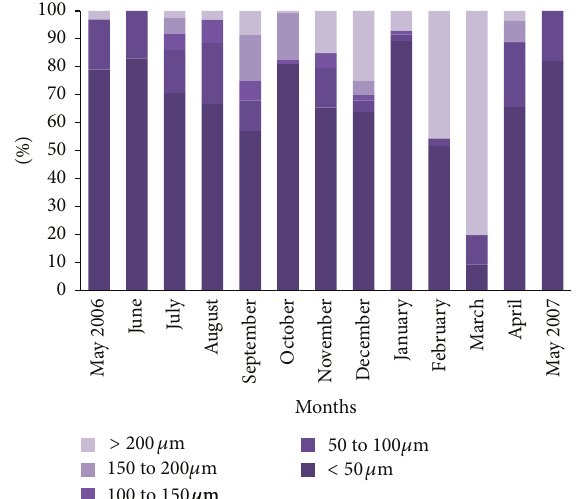
Figure 5: Size-frequency distribution of oocytes from May 2006 to May 2007.